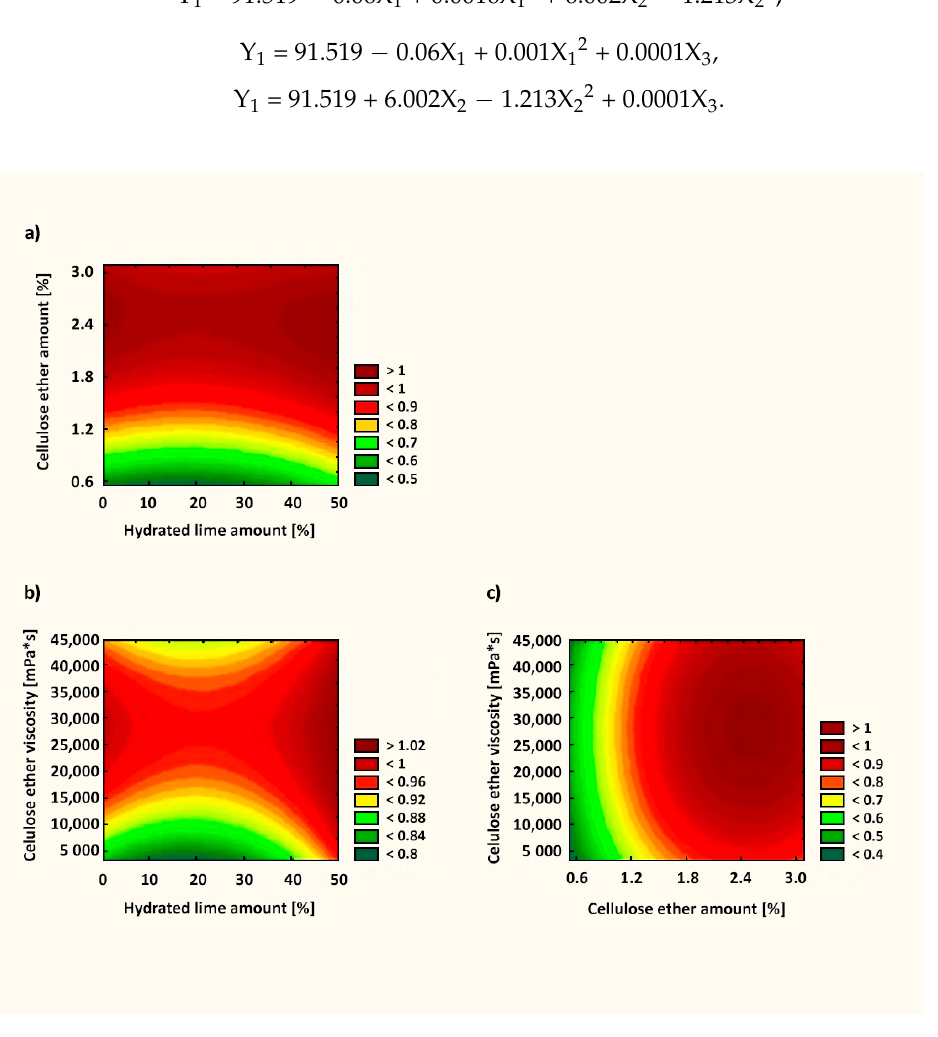
Statistically, the amount of hydrated lime and cellulose ether viscosity had a lesser effect on the parameter tested. As the amount of admixture in the mortars increased, the WRV10 increased. Thus, modifying plasters with cellulose ether is a favorable solution from the point of view of water retention in the mortar. The utility level shown in the range from 0 to 1 in Figure 6 determines the influence of the defined factors on the tested parameter, suggesting the optimal arrangement of the factors X 1 , X 2 , and X 3 . Adding as little as 1.2% cellulose ether enabled obtaining a high WRV10 (Figure 6).